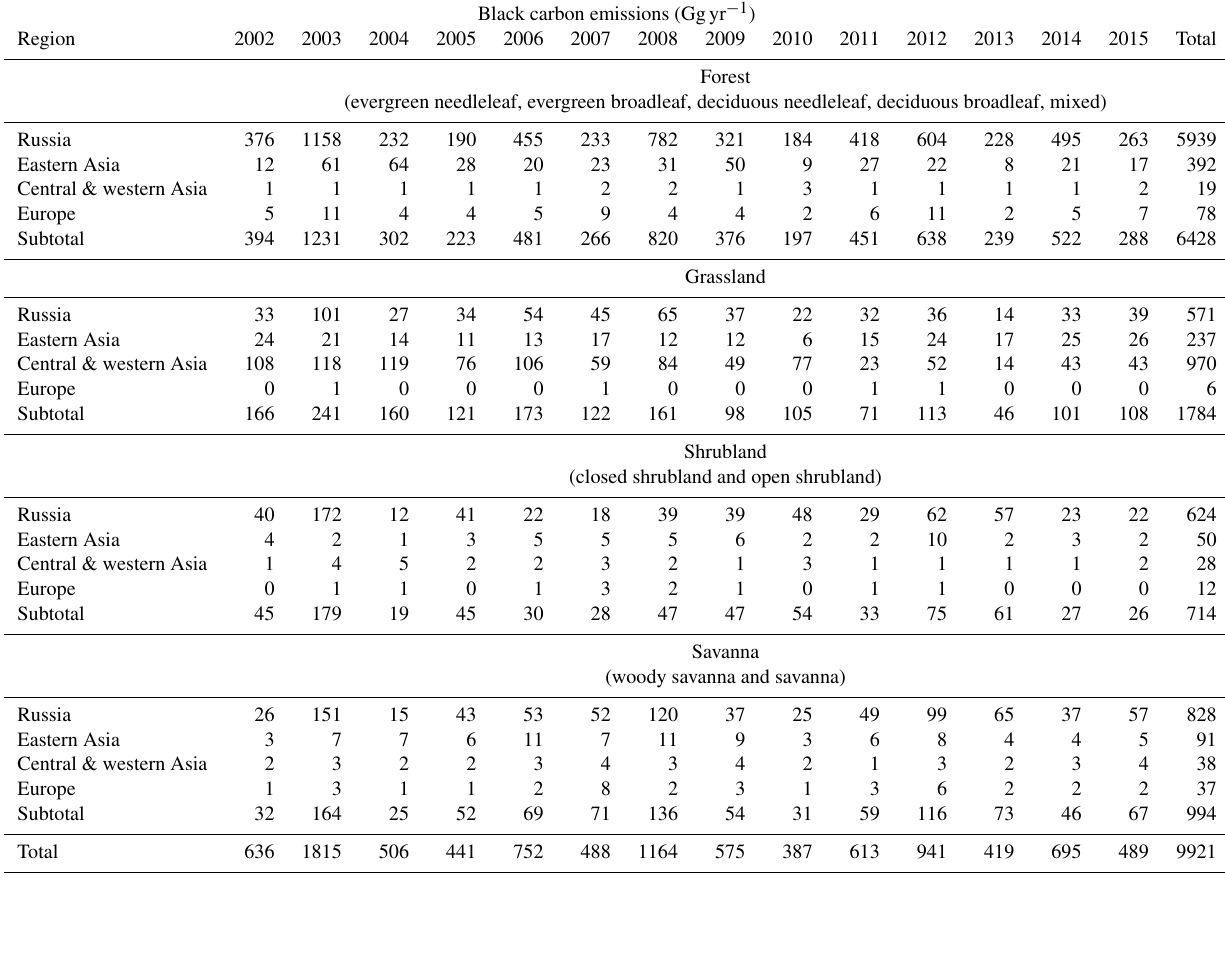
Table 1. Annual BC emissions in different land cover types over different geographic regions in northern Eurasia from 2002 to 2015.